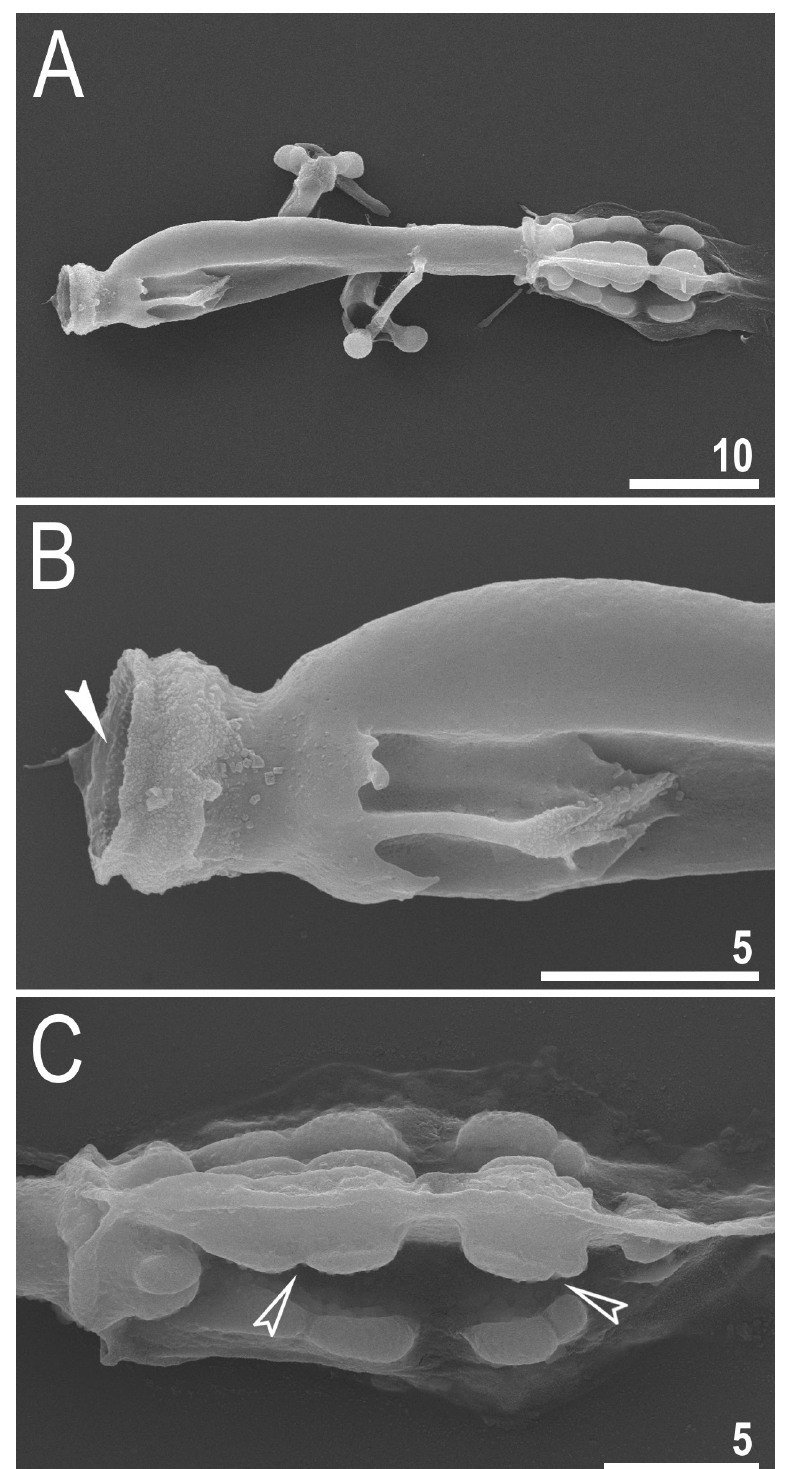
Fig. 17. Tenuibiotus zandrae sp. nov. Buccal apparatus seen in SEM (paratype). A . Entire buccal apparatus. B . Lateral view of the buccal crown. C . Placoids. Filled indented arrowhead indicate the first band of teeth in the oral cavity, empty indented arrowheads indicate the central constriction in the first macroplacoids and the subterminal constriction in the second macroplacoid. Scale bars in